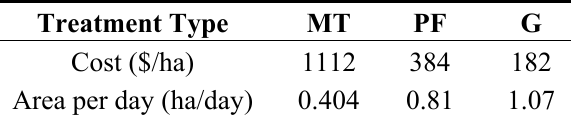
Table 4. Fuel treatment